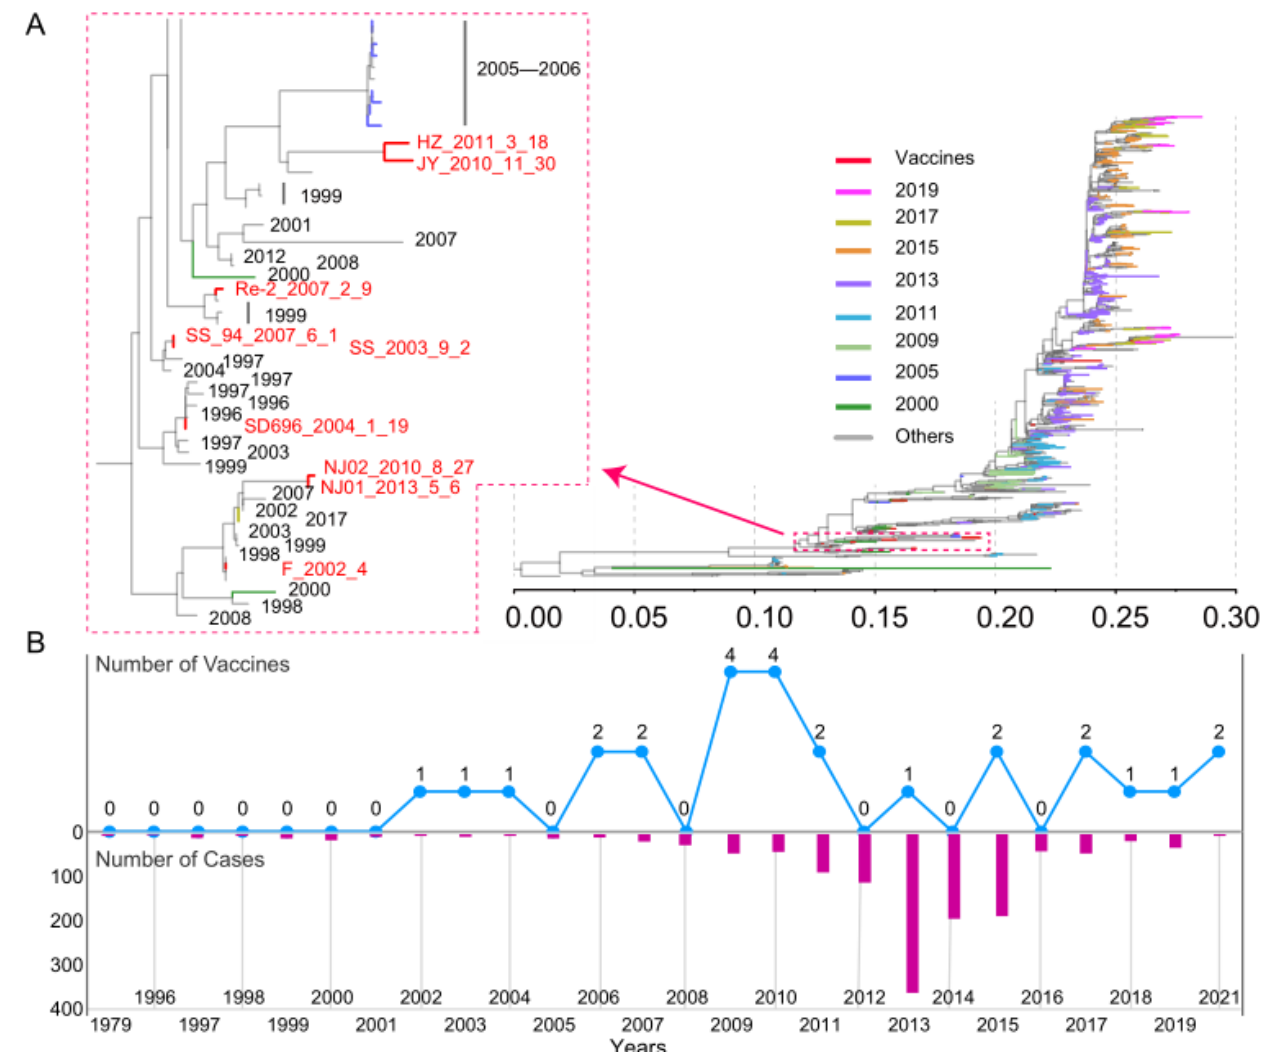
Figure 2. Phylogenetic analysis of the hemagglutinin (HA) gene in H9N2 AIVs. ( A ) Different colored branches represent different data collection times. An enlargement of the more distributed branch of the HA sequence of the inactivated vaccine is shown on the left. ( B ) Line chart of the approved inactivated vaccines over time and a bar chart of the number of H9N2 influenza virus infections.